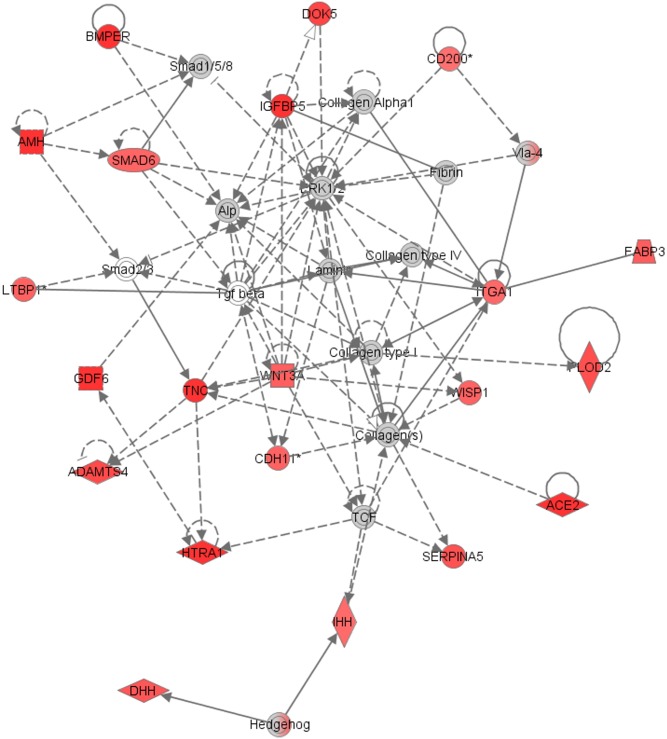
Top network enriched in cumulus cells (Enrichment score: 41) generated with Ingenuity Pathway Analysis (IPA).The network is associated with cellular development, skeletal and muscular system development and function and tissue development. Up-regulated genes in our study are marked in red colour; the colour intensity of the nodes indicates the degree of up-regulation. Transcripts in grey were not differentially expressed. Genes are represented as nodes, and the biological relationship between two nodes is represented as a line: the plain line indicates direct interaction, the dashed line indicates indirect interaction; the line without arrowhead indicates binding only, the line finishing with a vertical line indicates inhibition; the line with an arrowhead indicates ‘acts on’.